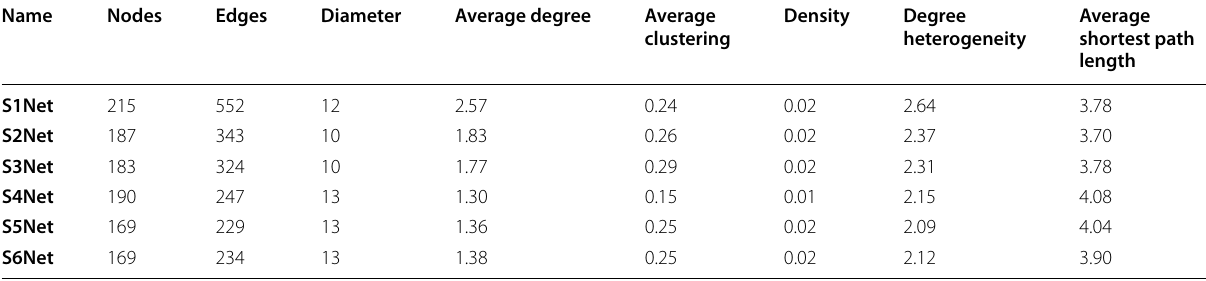
Table 1 Basic network information indicators of the six active networks